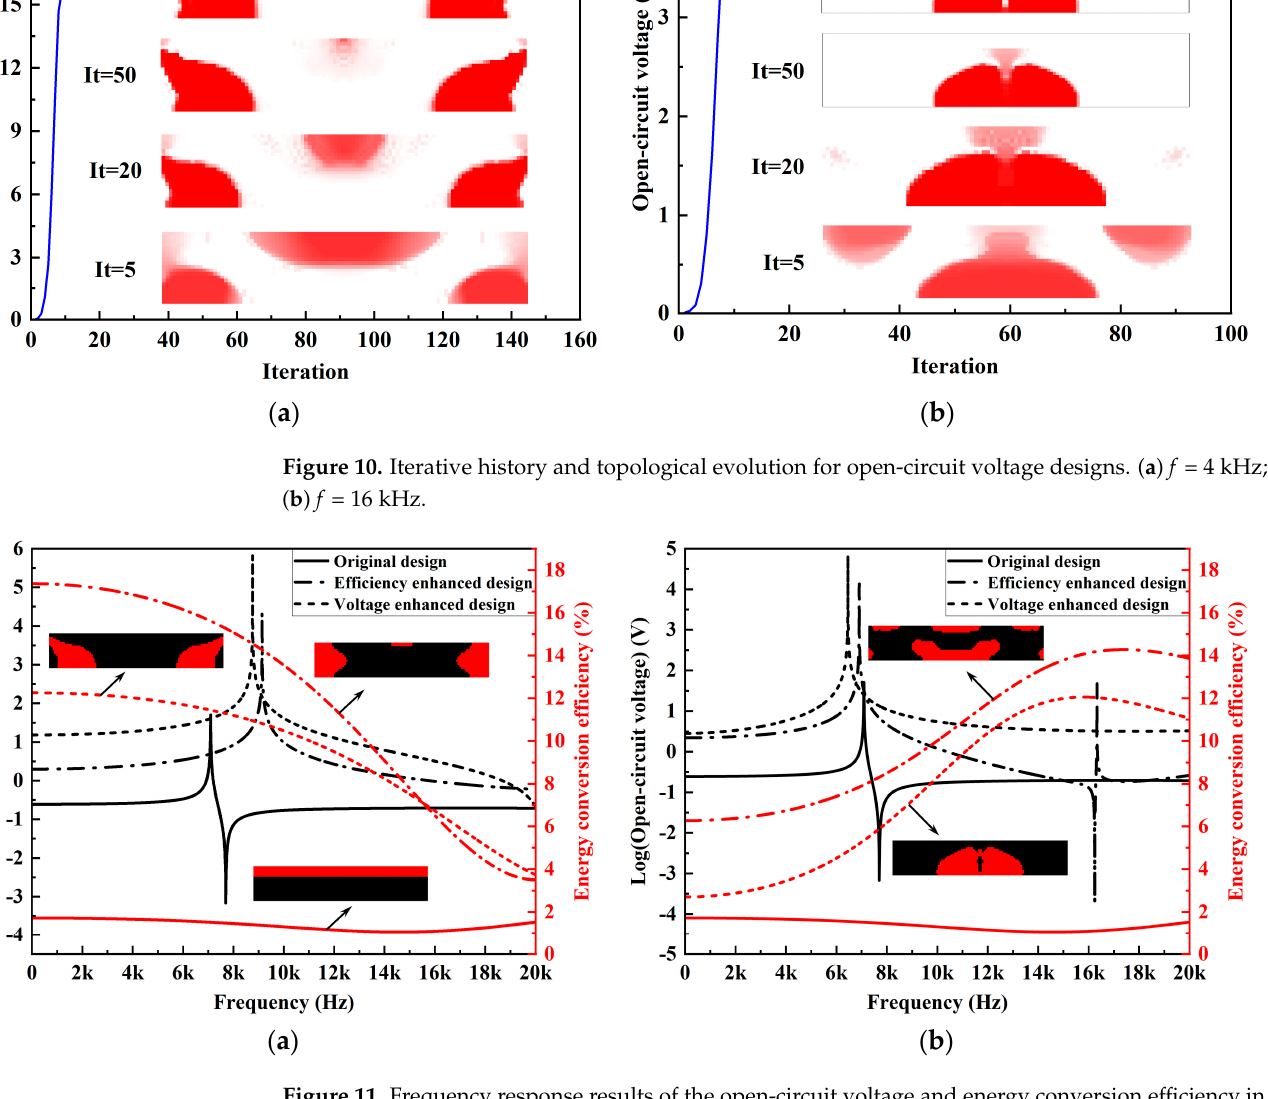
Figure 11. Frequency response results of the open-circuit voltage and energy conversion efficiency in different designs. ( a ) f = 4 kHz; ( b ) f = 16 kHz.